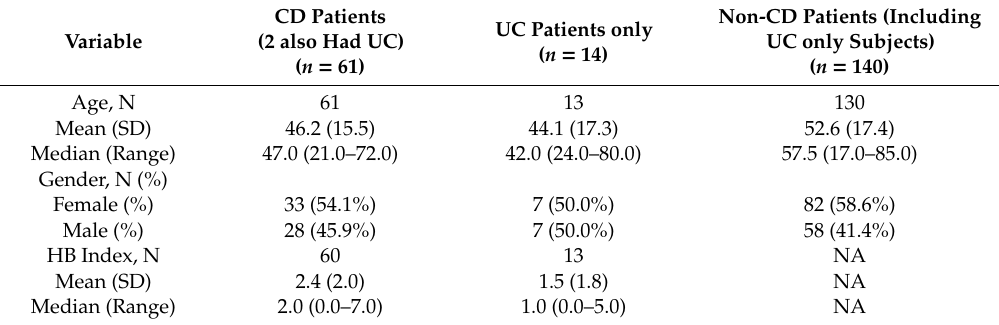
Table 1. Demographics and Clinical Characteristics by Subgroups ( n = 201).